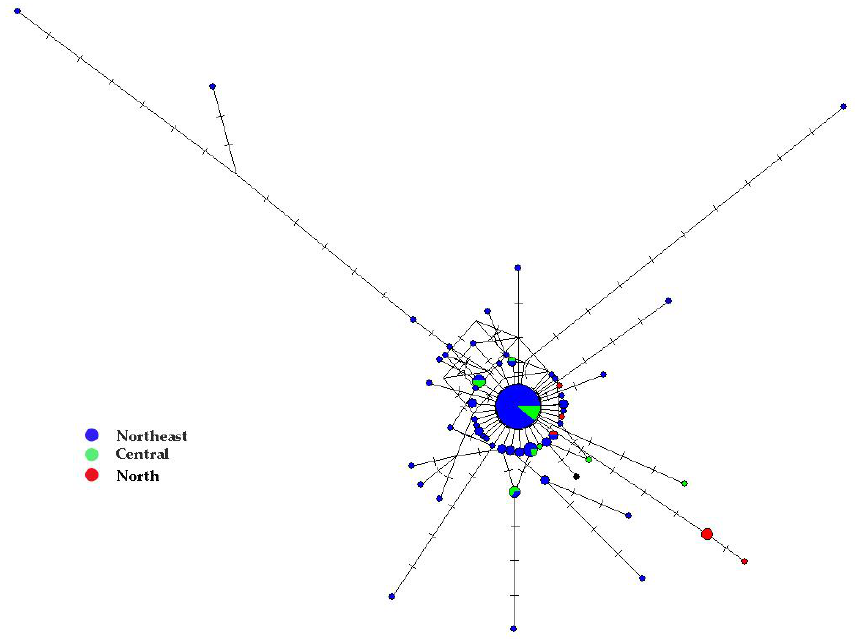
Figure 3. Median joining network of 123 mitochondrial cytochrome c oxidase I (COI) sequences of Culicoides mahasarakhamense in Thailand. Each circle represents a haplotype and sizes are relative to the number of individuals sharing such haplotypes. Haplotypes are labelled according to the geographic region as in Figure 1. Crossbars indicate mutation steps.